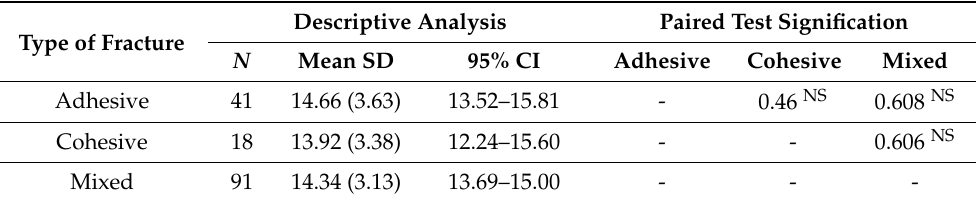
Table 4. Comparative inferential analysis: 1-factor ANOVA. Bond strength for resistance to fracture, depending on the type of